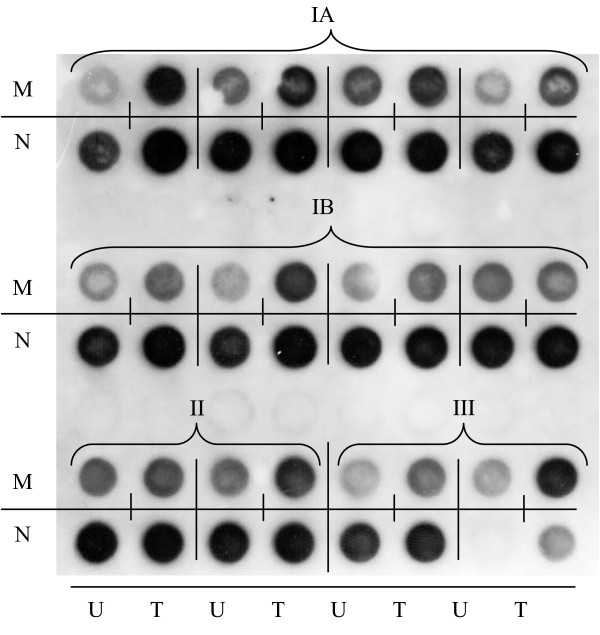
T and sialyl-T antigens are expressed in bladder tumor tissue and urothelium. Tumor (T) and Urothelium (U) samples from patients were analyzed by dot blot staining with PNA, which binds to T-antigen. Samples were arranged by tumor type, namely, nonmuscle-invasive without (IA) and with recurrence (IB) and muscle-invasive (II) bladder cancer and non-malignant tumors (III) and by treatment with neuraminidase (N) or mock treated (M). PNA binds to non neuraminidase treated samples, of all patients' groups, indicating the presence of T-antigens. In the majority of the samples, PNA binding is strongly increased after neuraminidase treatment.